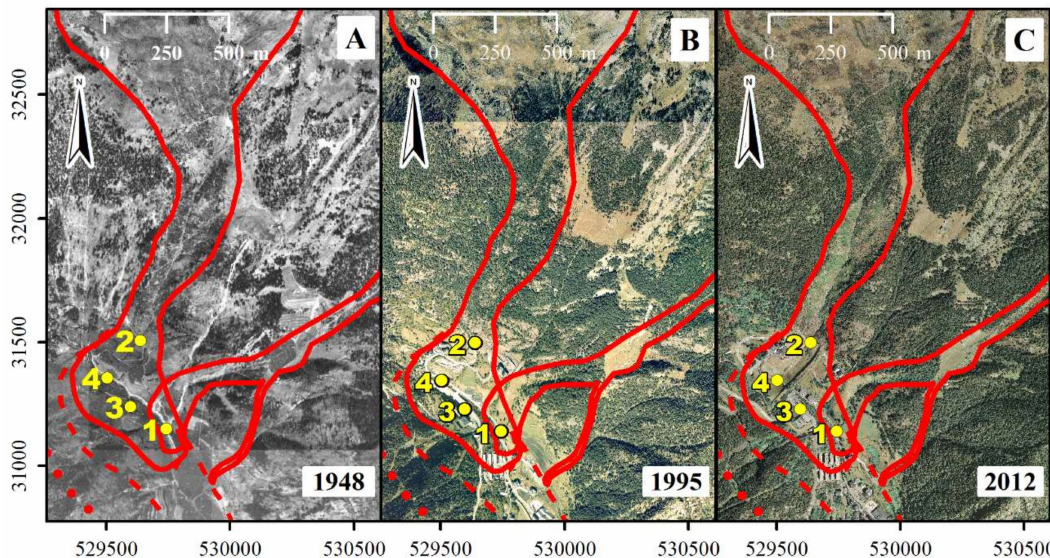
Figure 2. Orthophotographs covering the track and run-out zones of the avalanche paths of LFd’A (west red contour) and Percanela (east red contour) (Coordinates: NFT (Paris) Lambert South France, EPSG 27563). Changes in vegetation in the track zone, especially forest density, can be clearly seen mostly due to avalanche activity: ( A ) in 1948, after an avalanche that occurred earlier in the decade); ( B ) in 1995, with the regenerated forest, just before the 1996 avalanche; ( C ) in 2012, showing the e ff ects of the 1996 avalanche on vegetation. Yellow dots and numbers indicate the approximate run-out of the historical avalanches: (1) the reach of the wet avalanche in the early 1940s; (2) the reach of the avalanche that occurred between the first avalanche and the last one in the 1960s; (3) the minimum run-out of the last avalanche in the 1960s; (4) the reach of the 2015 wet